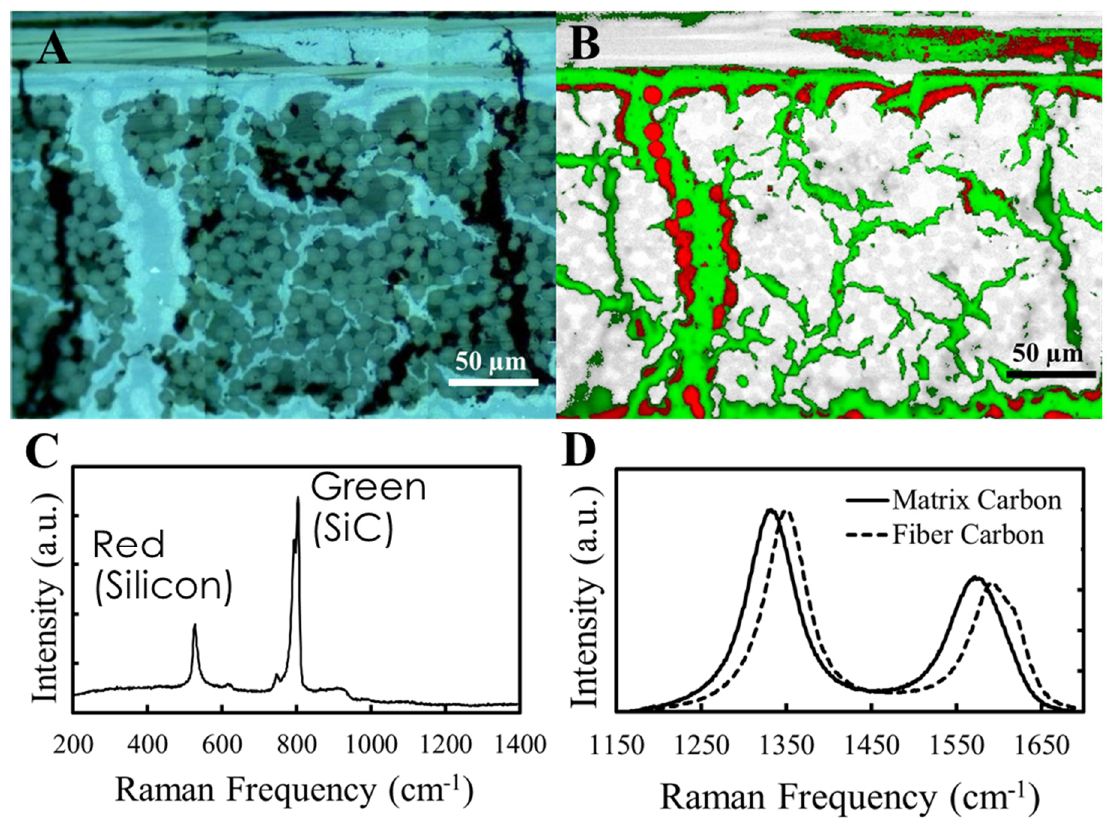
Figure 9. (A ) Optical image of cross ‐ section and ( B ) overlay of Raman maps, ( C ) average Raman Figure 9. ( A ) Optical image of cross-section and ( B ) overlay of Raman maps, ( C ) average Raman spectra of the final C/C ‐ SiC composite showing Si and SiC, and ( D ) average Raman spectra of the spectra of the final C/C-SiC composite showing Si and SiC, and ( D ) average Raman spectra of the final C/C ‐ SiC composite showing carbon matrix and carbon fibers. final C/C-SiC composite showing carbon matrix and carbon